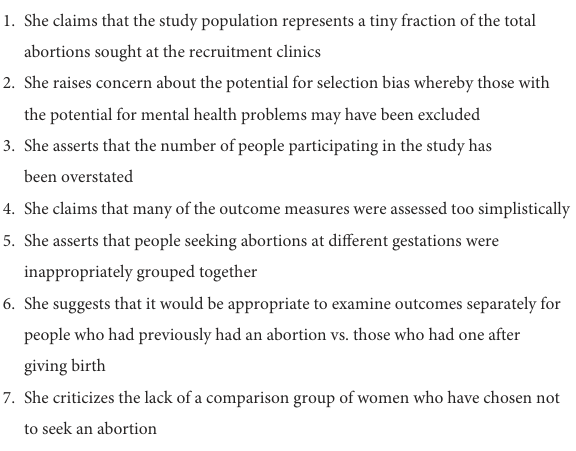
TABLE 1 Coleman’s critiques of Turnaway Study